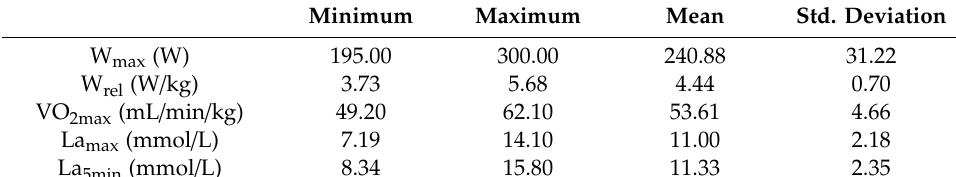
Table 3. Descriptive statistics of all performance-related parameters.